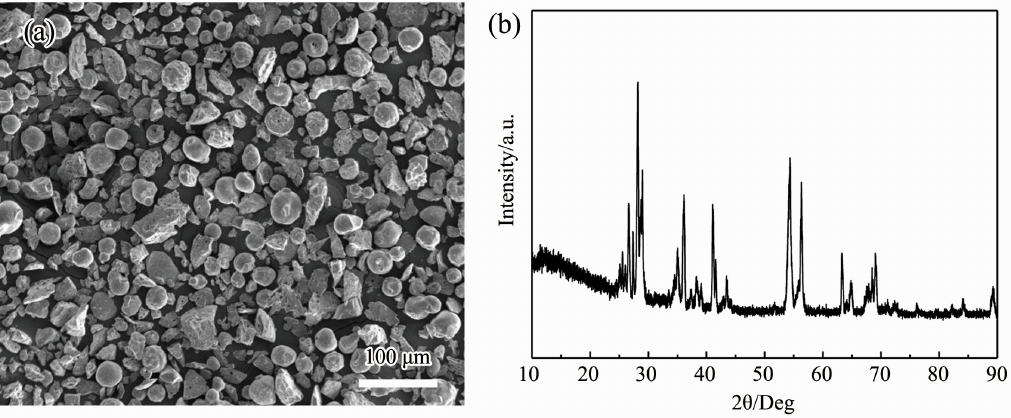
Figure 1. ( a ) SEM morphology and ( b ) XRD pattern of feedstock powders.